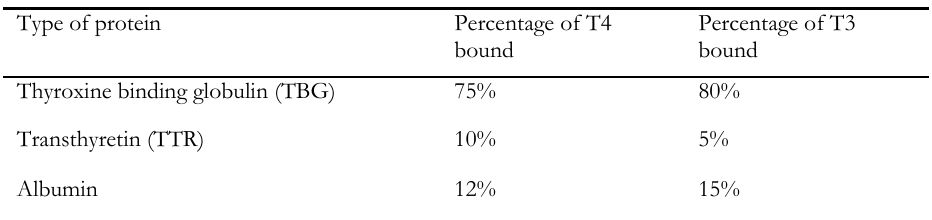
Table 1.1. Transport of TH and binding proteins